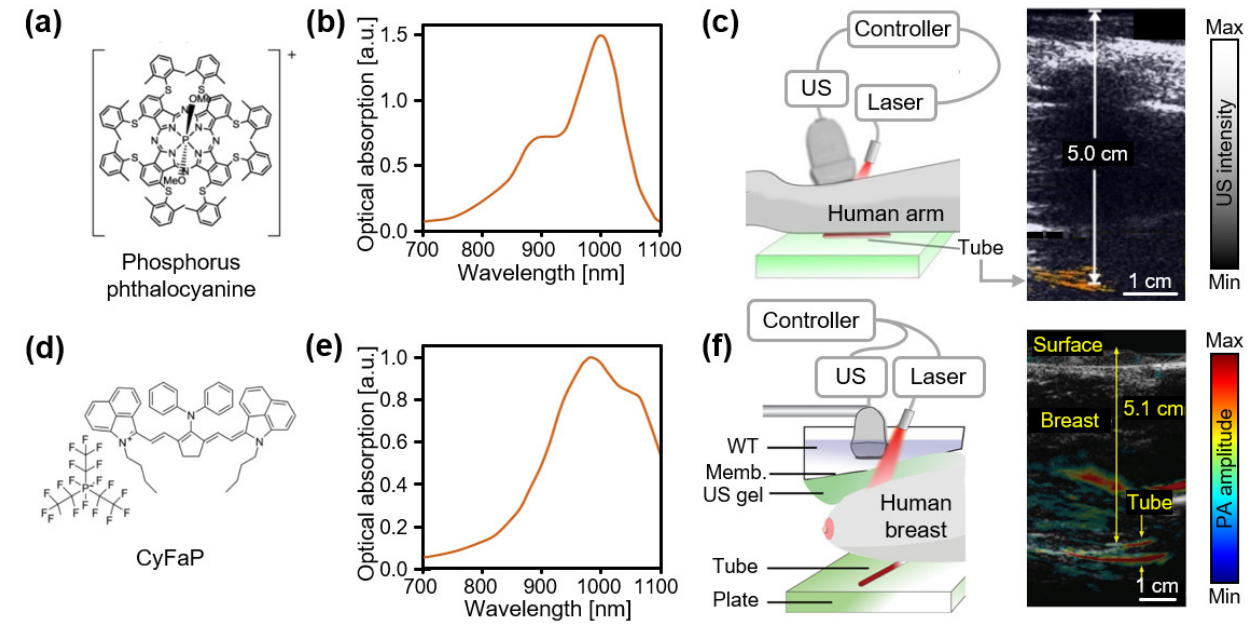
Figure 7. Contrast-enhanced PA images of organic dyes in the NIR-II region. ( a ) Chemical structure of a phosphorus phthalocyanine. ( b ) Optical absorption spectrum of a phthalocyanine-based dye. ( c ) Schematic illustration and contrast-enhanced PA images for evaluating deep tissue imaging through a human arm. Reprinted with permission from Ref. [107]. 2016, Ivyspring. ( d )